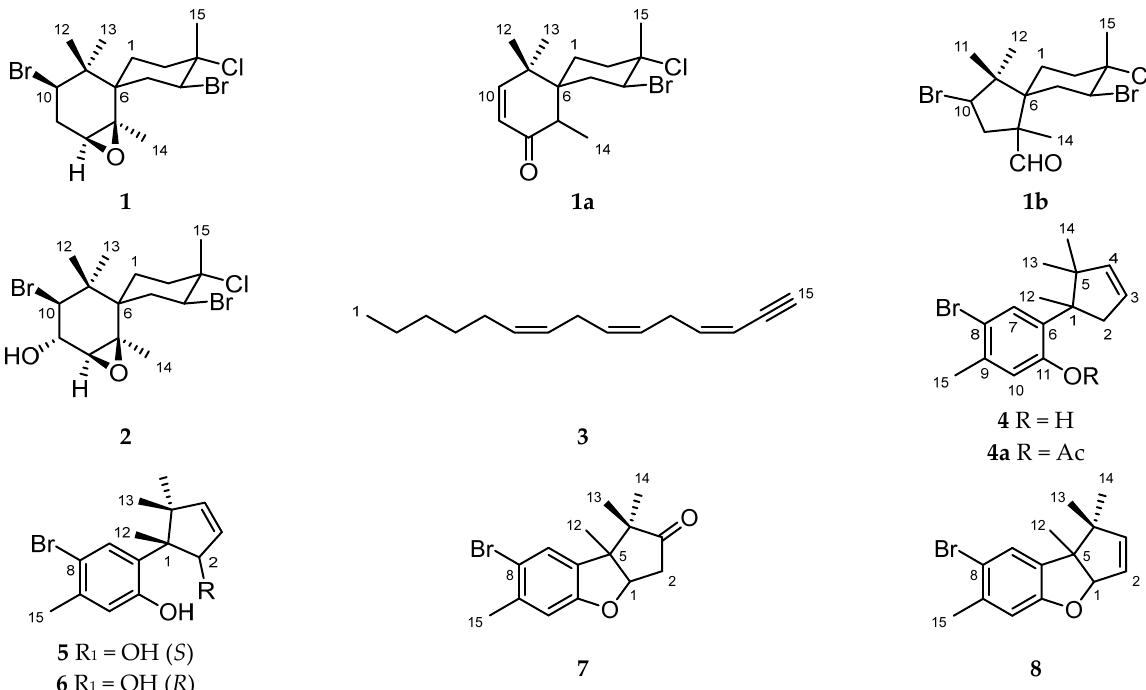
Figure 1. Compounds 1 – 8 isolated (and derivatives produced) from the South African Laurencia corymbosa